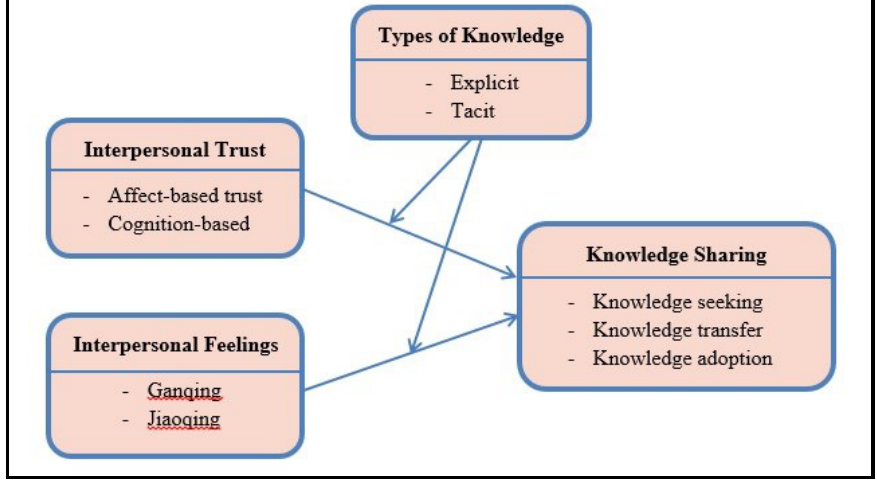
Figure 1: A Conceptual Model of Trust, Feelings & Knowledge